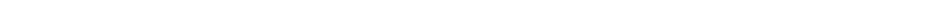
(see fi gure on previous page) Fig. 7 CHD6 transcriptionally regulates TMEM65 by cooperating with TCF4. a HCT116 cell lysates were immunoprecipitated with an anti-CHD6 antibody and were immunoblotted with the indicated antibodies. b Representative immunoblot analysis of fractions containing protein complex eluted from size exclusion chromatography. Cell lysate extracted from CHD6-transfected HEK293T cells was analyzed for CHD6-containing complexes using Superose 6 (GE) gel fi ltration column. Eluted fractions of protein complex were collected and revealed by immunoblotting with the indicated antibodies. CHD6, TCF4, and β -catenin were co-eluted at fractions 29 – 32. c TCF4 binding motif obtained from JASPAR (top). The potential binding site of TCF4 on the promoter of TMEM65 (bottom). d ChIP of CHD6 and IgG in control or CHD6 KD HCT116 cells, followed by qPCR for the loci identi fi ed by searching for binding sites on TMEM65 promoter. e ChIP of TCF4 and IgG in control and CHD6 KD HCT116 cells followed by qPCR for the loci of predicted binding sites on TMEM65 promoter. f RT-qPCR analysis of TMEM65 mRNA in HCT116 cells treated with Wnt pathway inhibitors IWR-1- endo (20 μ M), XAV-939 (1 μ M), or vehicle. g RT-qPCR analysis of TMEM65 mRNA in HCT116 cells cultured with L-Wnt3a-expressing cell CM. h RT-qPCR analysis of TMEM65 mRNA in HCT116 cells cultured with L-Wnt3a-expressing cell CM, in the presence or absence of Wnt pathway inhibitor IWR-1- endo (20 μ M). i TMEM65 -reporter luciferase activity in 293T cells with or without CHD6 overexpression. j TMEM65 -reporter luciferase activity in 293T cells with overexpression of β -catenin and TCF4 alone, or in combination. k TCF4 binding motif obtained from JASPAR (top). The potential binding site of TCF4 on the promoter of CHD6 (bottom). l ChIP of TCF4 and IgG in control or CHD6 KD HCT116 cells, followed by qPCR for the loci on CHD6 promoter. m Immunoblot and RT-qPCR analysis of CHD6 in HCT116 cells treated with Wnt pathway inhibitors LGK974. n Immunoblot and RT- qPCR analysis of CHD6 in HCT116 cells cultured with L-Wnt3a-expressing cell CM. o Immunoblot and RT-qPCR analysis of CHD6 in HCT116 cells cultured with L-Wnt3a-expressing cell CM, in the presence or absence of Wnt pathway inhibitors LGK974 (10 μ M). p ChIP of β -catenin and IgG in HCT116 cells, followed by qPCR for the loci on CHD6 promoter. Assays were performed with three replicates. P values were calculated by two-tailed t - test ( d , e , i , l , p ) or one-way ANOVA ( f – h , j , m – o ). Data are presented as means ± SD. *** P < 0.001, ** P < 0.01, * P < 0.05, ns, not signi fi